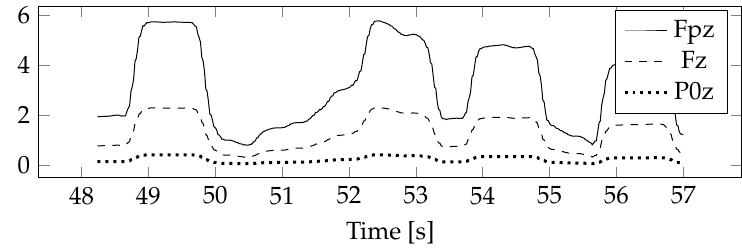
Figure 6. Standard deviations for electrodes at different distances from the